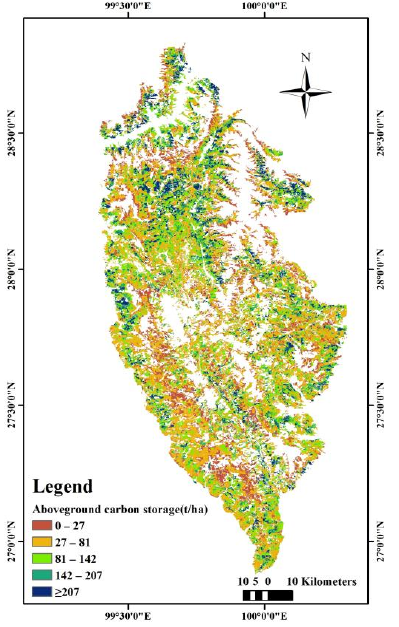
Figure 11. Aboveground carbon storage in Shangri-La City.